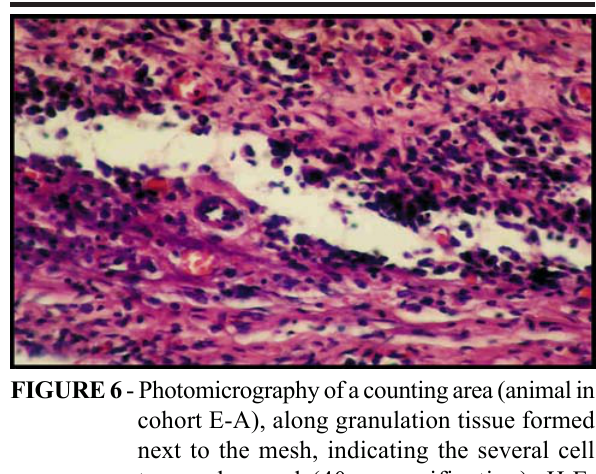
FIGURE 6 - Photomicrography of a counting area (animal in cohort E-A), along granulation tissue formed next to the mesh, indicating the several cell types observed (40x magnification).